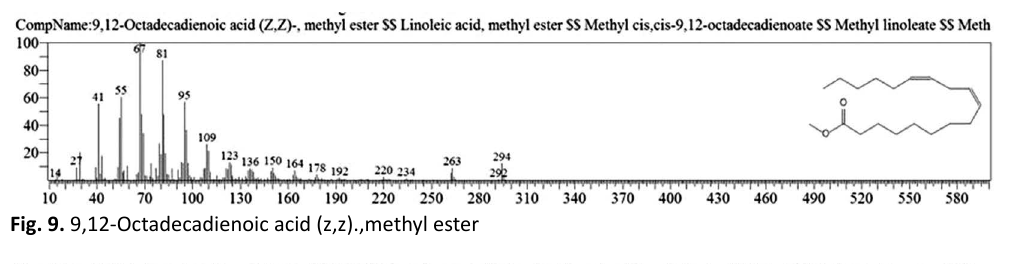
Fig. 8. Octanoic acid, methyl ester